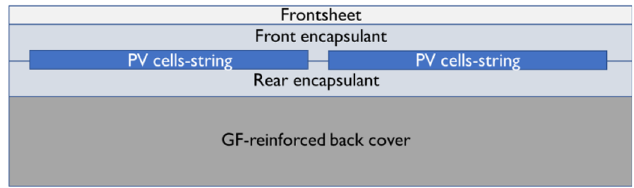
Fig. 8. Schematic buildup of a lightweight module with reinforced